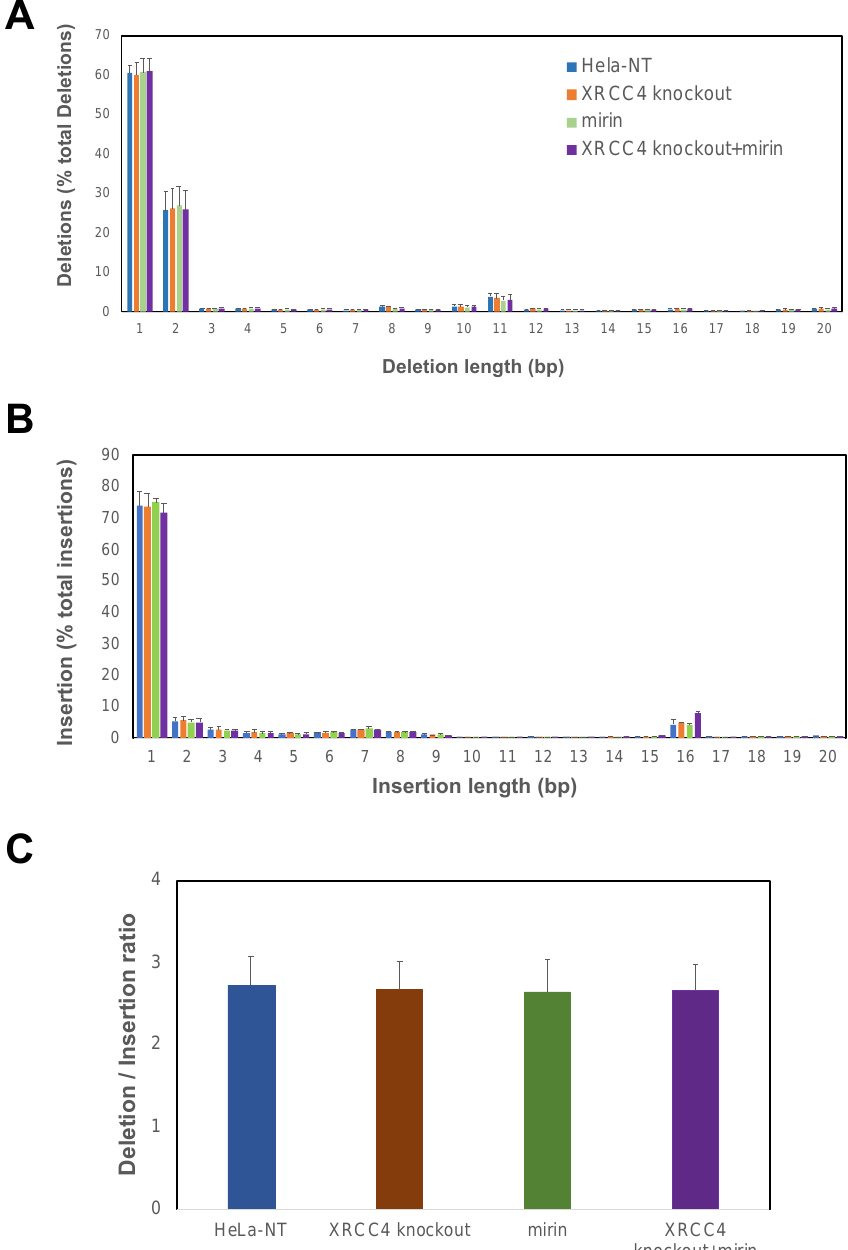
Figure 4. Editing profiles of HeLa cells with impaired repair pathways. Bar plots for the frequency of deletions ( A ) and insertions ( B ). Indel lengths are shown following DNA repair of TALEN-induced DNA damage. For each sample, we measured between 42,733 and 64,104 deletion and 19,598 and 25,620 insertion editing events. ( C ) Ratio of deletion to insertion Indels for HeLa cells with impaired repair pathways. Standard errors reflect duplicate measurements. The color key is in panel A.